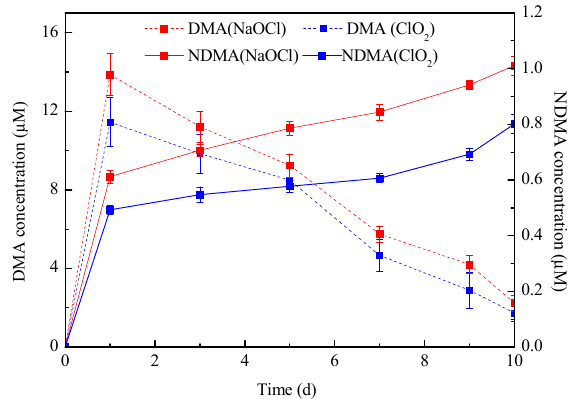
Figure 5. Dimethylamine (DMA) and NDMA formation during CIT oxidation with NaOCl and ClO 2 = 20 µ M, [NaOCl] = [ClO (C 0 = 20µM, [NaOCl] = [ClO 2 ] = 1 mM, pH = 7). (C 0